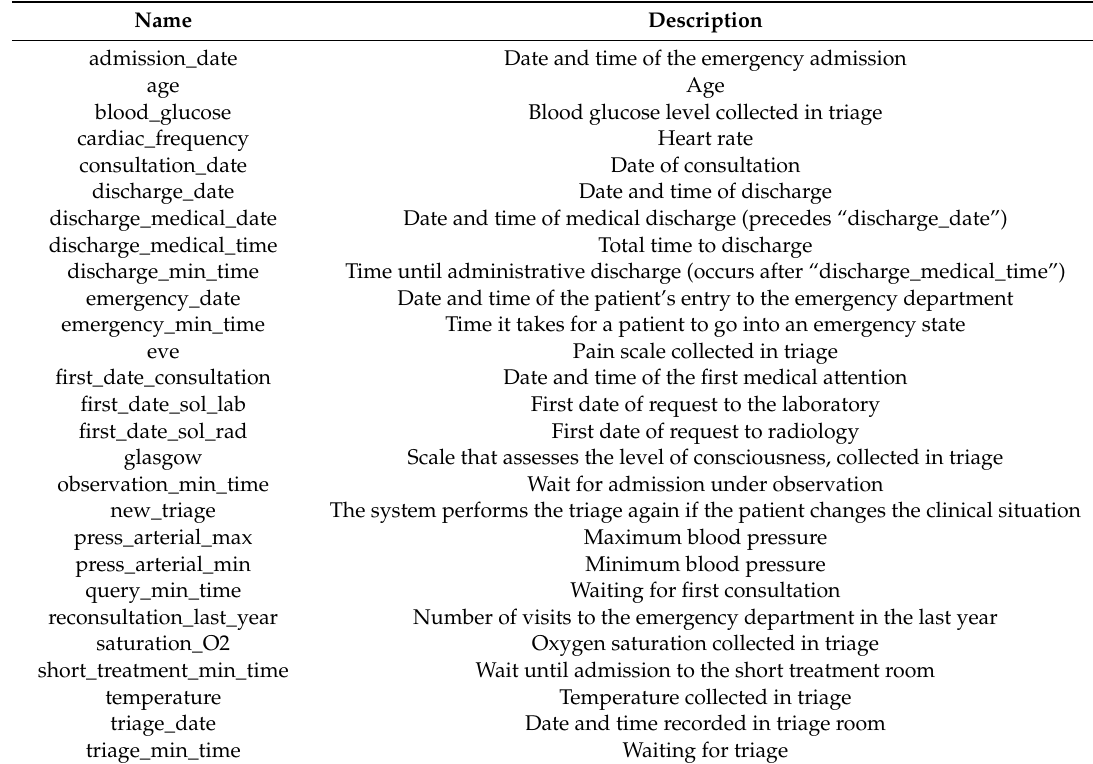
Table A2. Integer